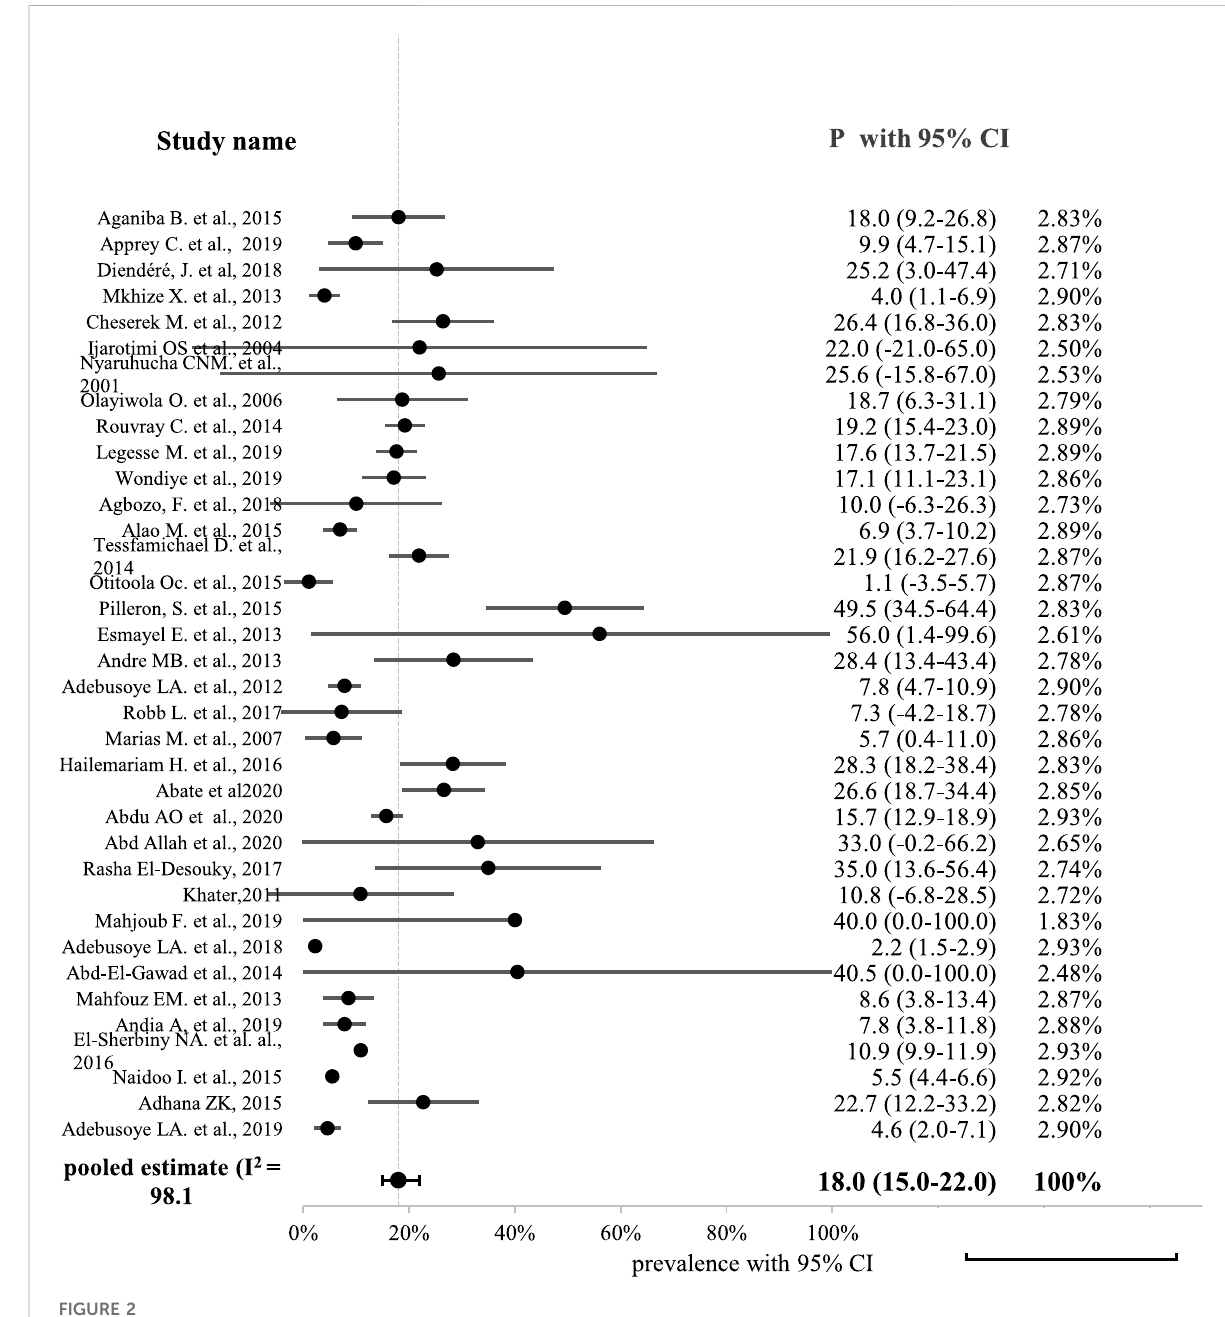
FIGURE 2 Forest plot displaying the pooled prevalence of malnutrition among old age people in